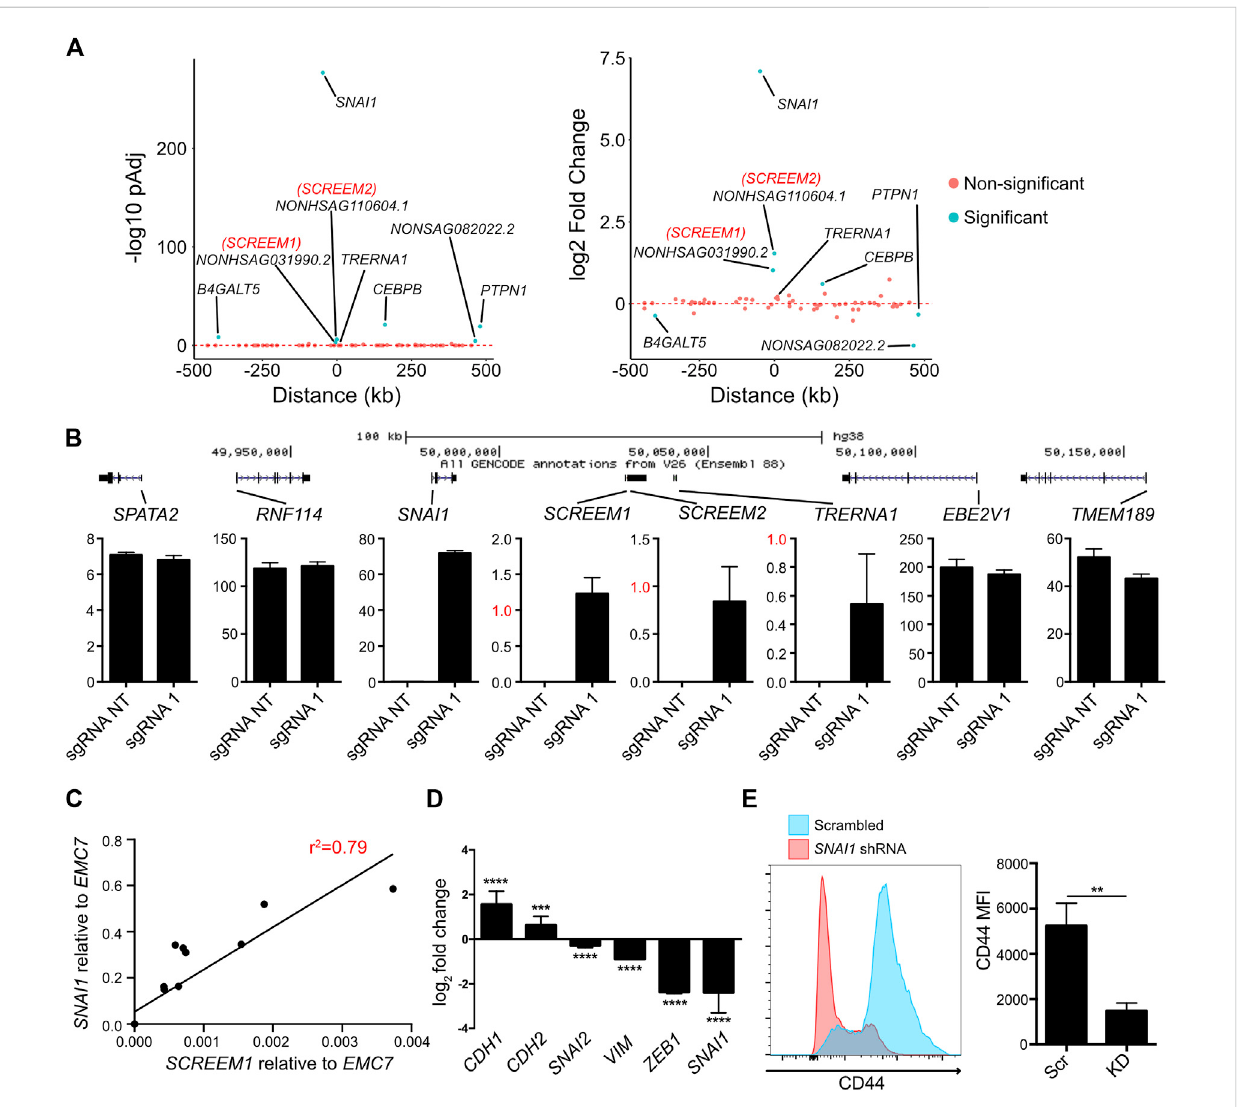
FIGURE 3 Activation of the SCREEM1 locus induces SNAI1 expression. (A) Plots showing p -value (left) and fold change (right) of genes within 1 mb region surrounding the SCREEM1 locus from RNA-Seq data described in Figure 2. (B) (Top) A scale diagram of SCREEM1 locus and proximal genes. (Bottom) Expression in TPM values of indicated genes between from RNA-Seq data described in Figure 2. SD; n = 3; NT, non-targeting; sgRNA1, SCREEM1 locus targeting — sgRNA1. (C) Correlation between relative levels of SCREEM1 (RT-PCR, normalized to EMC7 ) and relative levels of SNAI1 (RT-PCR, normalized to EMC7 ) following activation of the SCREEM1 locus. Statistics, simple linear regression. (D) RT-PCR analysis of EMT-associated gene expression in SNAI1 -attenuated HBEC3-KT cells with concomitant CRISPR-activation of SCREEM1 locus. Plotted are log2 fold changes of delta-delta Ct values relative to scrambled and EMC7 . All values are mean ± SD with n = 3. Statistics, unpaired t -test, **** p < 0.0001; *** p < 0.00. (E) Left plot shows representative fl ow cytometric data of CD44 expression on SNAI1 -attenuated and Scrambled control HBEC3-KT cells with concomitant CRISPR- activationof SCREEM1 locus(sgRNA1).Rightplotshowsmean fl uorescentintensityof(MFI)CD44levelson SNAI1 -attenuated(KD)andScrambledcontrol (Scr) HBEC3-KT cells with concomitant CRISPR-activation of SCREEM1 locus (sgRNA1). All values are mean ± SD with n = 3; Statistics, unpaired t -test, ** p <